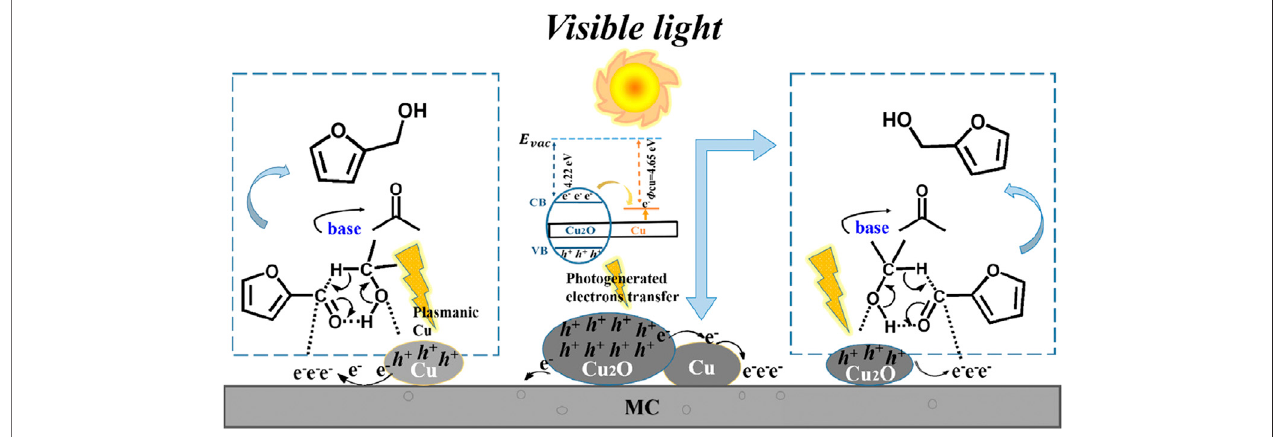
FIGURE 12 | Schematic representation of furfural hydrogenation to furfuryl alcohol on the Cu@C catalyst.